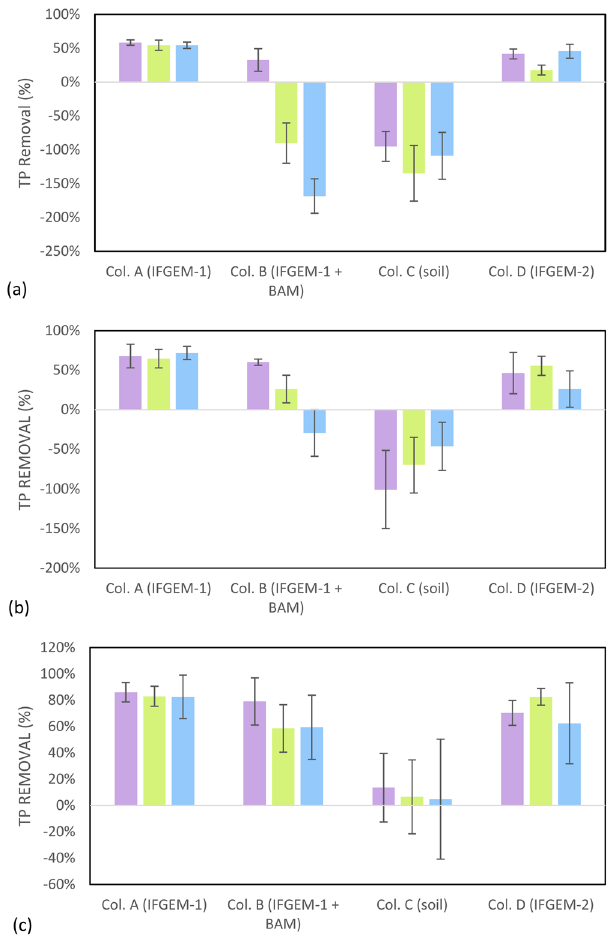
Figure 7. Outcome of the column study: total phosphorus removal when the inlet TP = ( a ) 0.3 mg/L, ( b ) 0.5 mg/L, and ( c ) 0.7